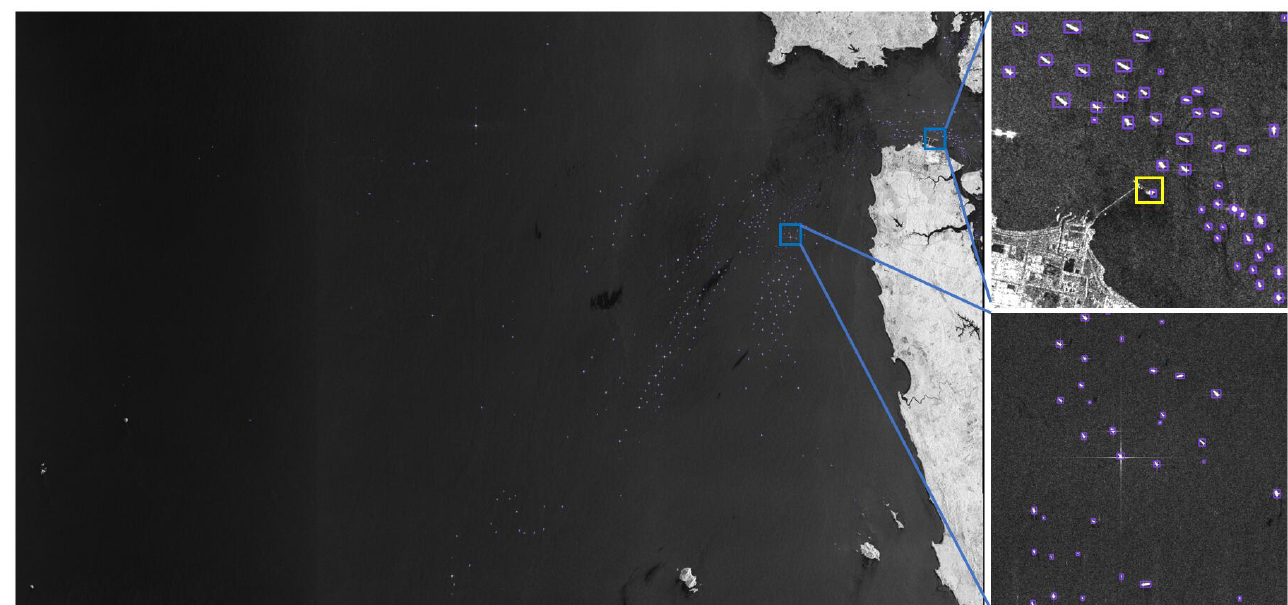
Figure 22. The visualized SAR ship detection result on Image 1.